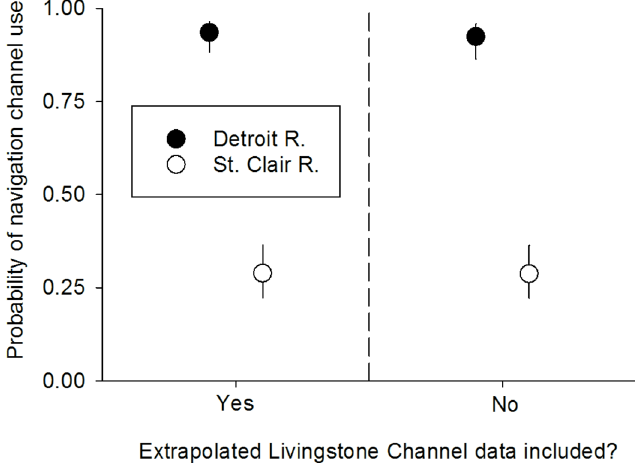
Fig 7. Probability (mean ± 95% confidence interval) of navigation channel use by acoustic-tagged Lake Sturgeon in the lower Detroit and St. Clair rivers when analysesincluded and excluded the extrapolated Livingstone Channel passage data. Upstreamand downstreampassageswere pooled becausedirectionof sturgeon movement for the extrapolated sturgeon passagedata was unknown.Expected probabilities of navigationchanneluse under the null model are shown as